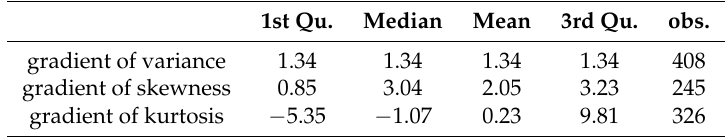
Table 6. Spline gradients summary statistics: statistically significant results only.